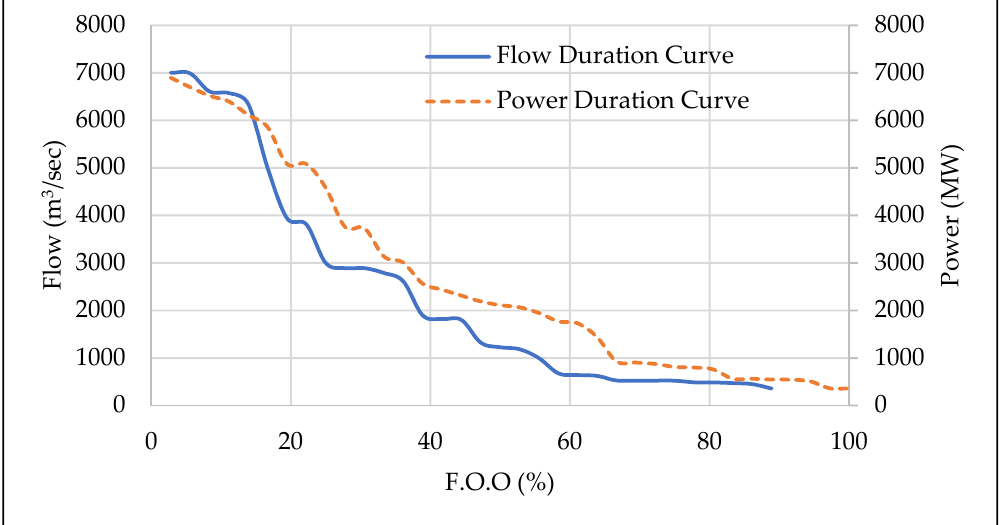
Figure 38. Flow and Power Duration curves of year 2020.